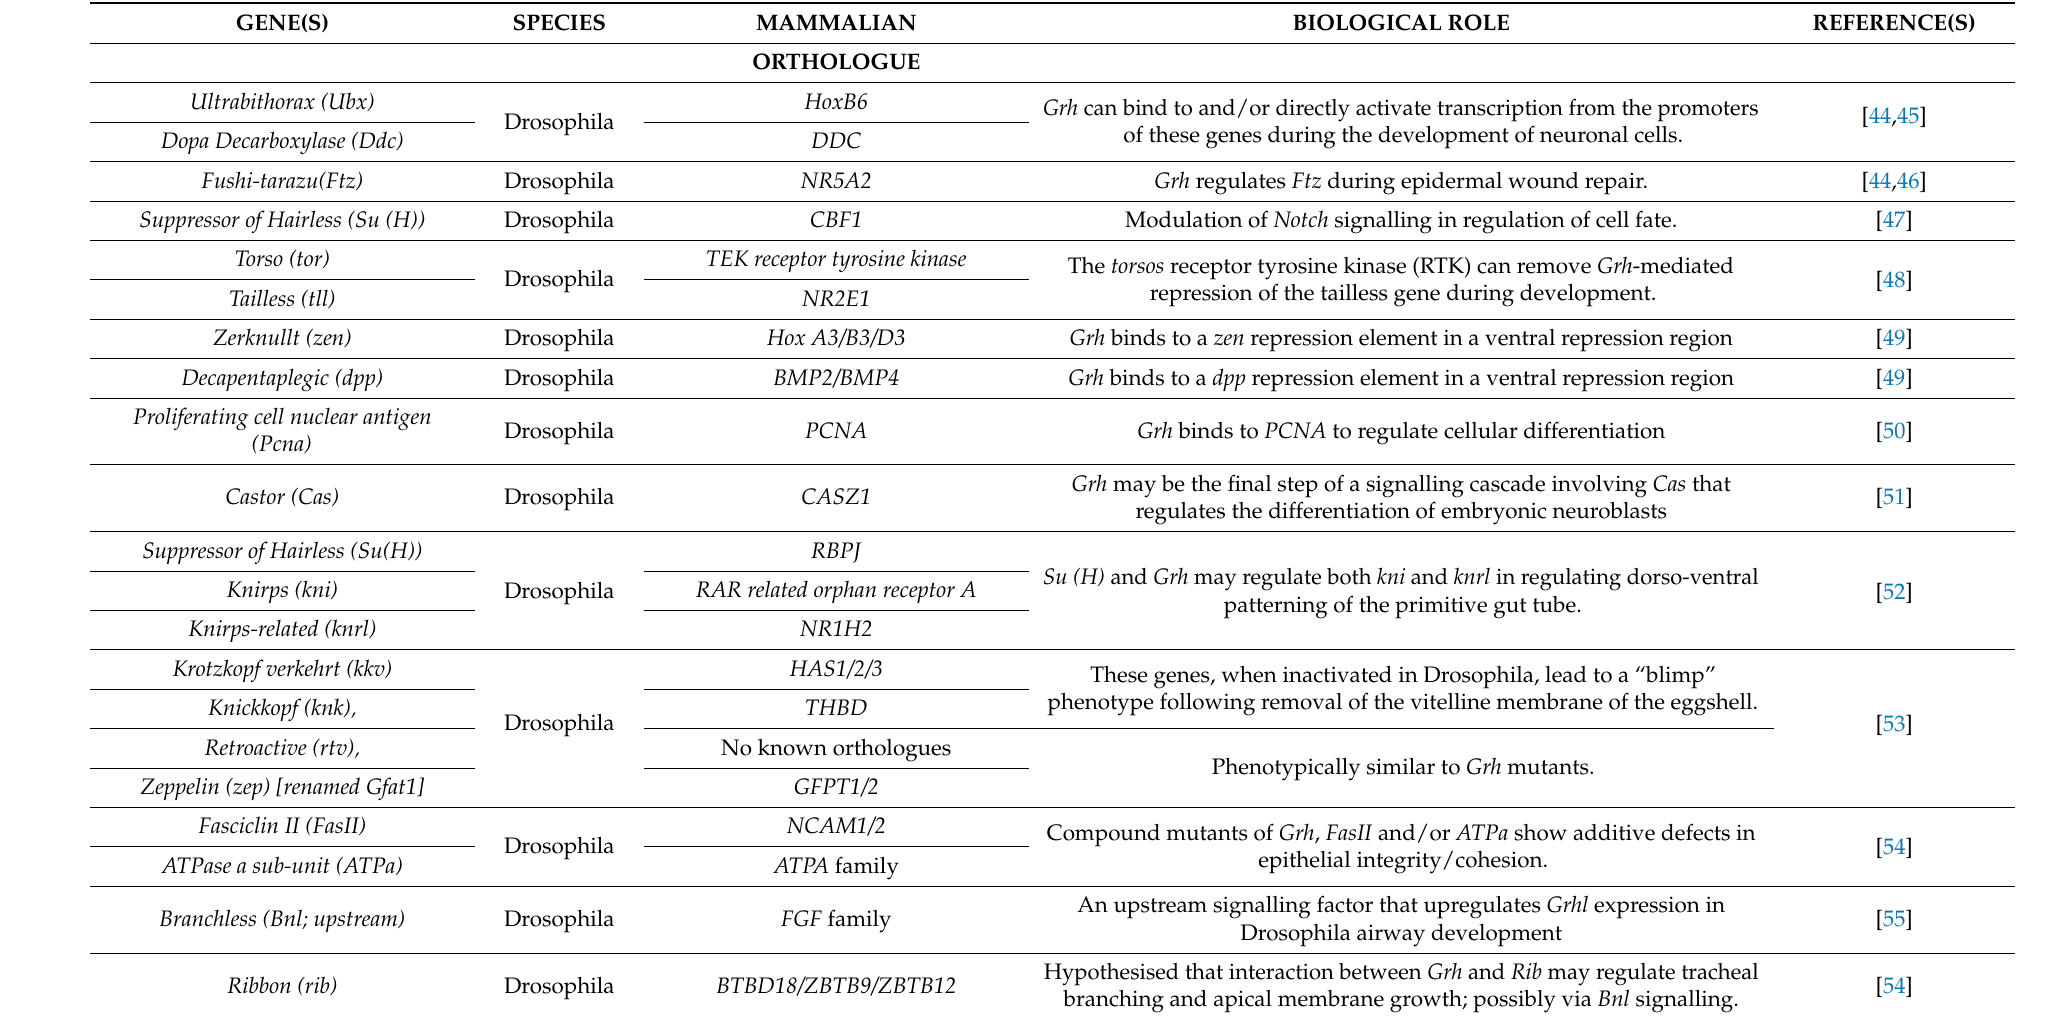
Table 1. Known or hypothesised direct target genes of grh characterised in invertebrate species, namely the fruit fly Drosophila, the honeybee ( Apis mellifera ) and the nematode model C.